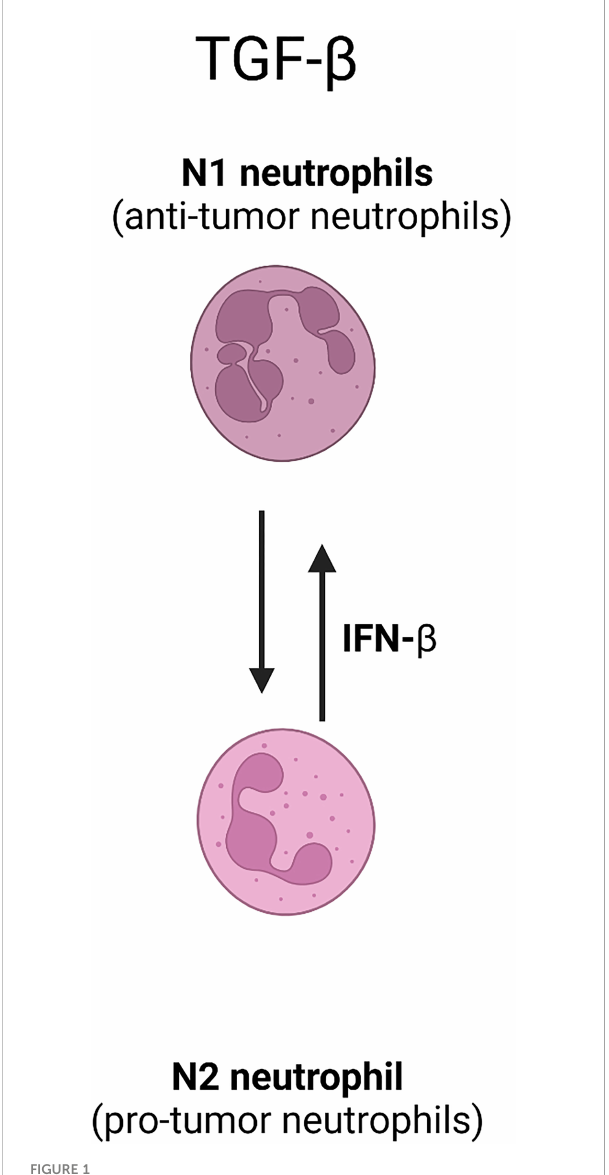
FIGURE 1 The involvement of TGF- b in neutrophil